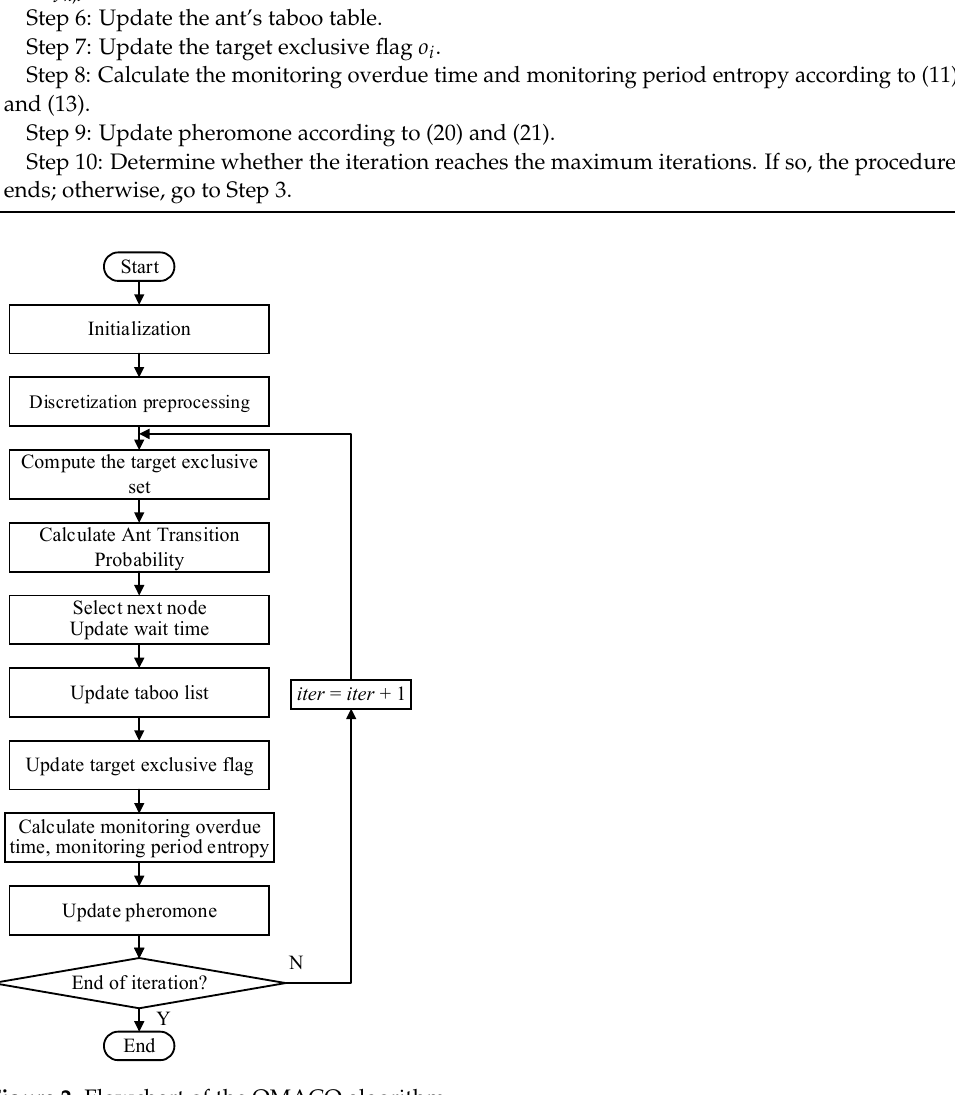
Figure 2. Flowchart of the OMACO algorithm.